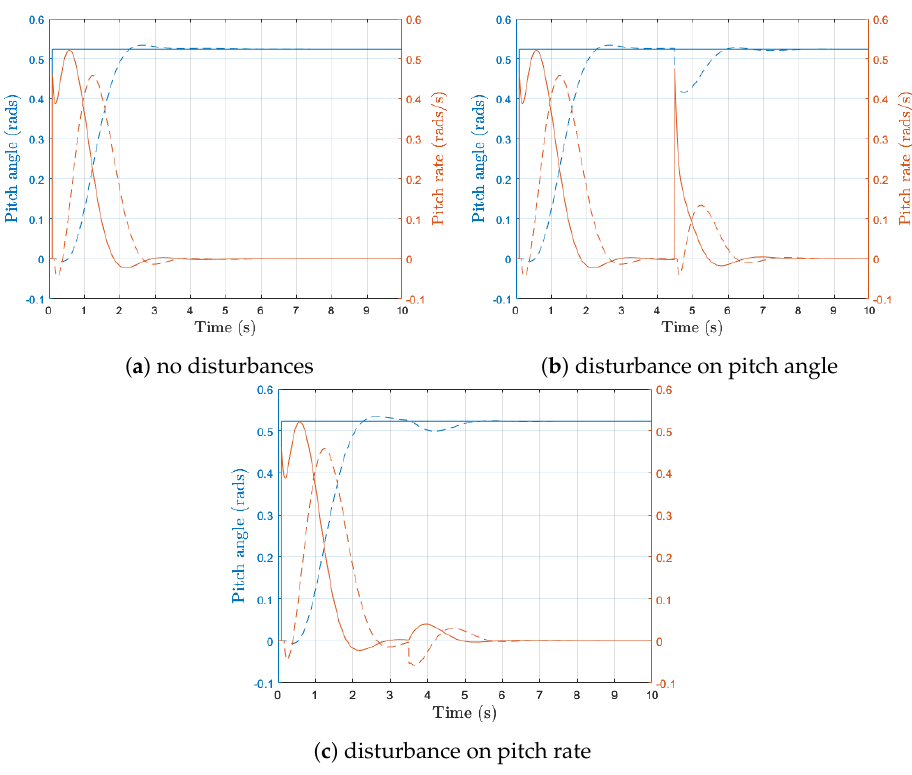
Figure 16. IMC–i outer loop control responses in time domain.